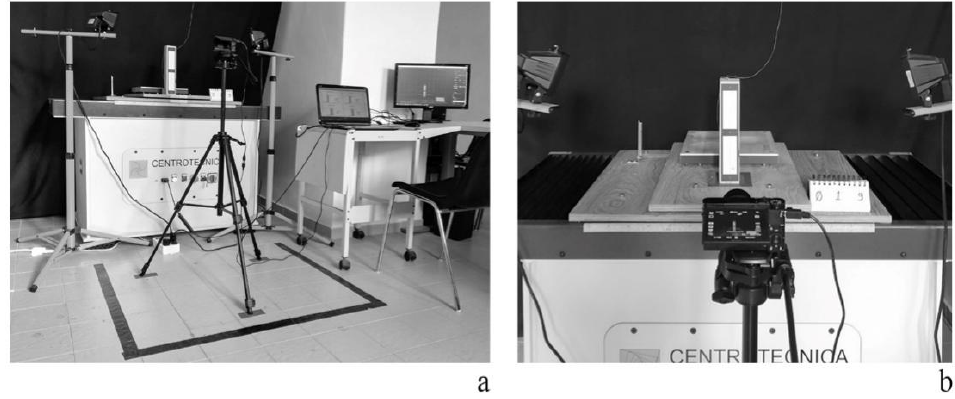
Figure 3. Experimental setup ( a , b ).